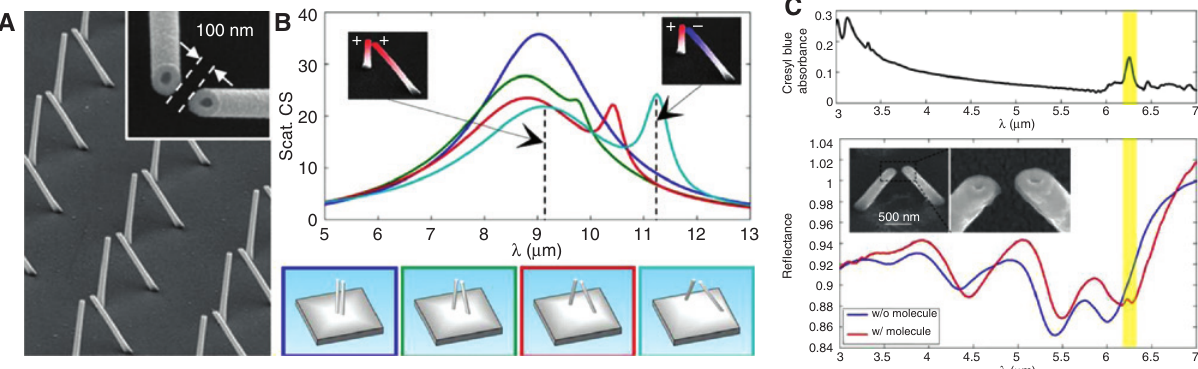
Figure 6: (A) Scanning electron microscopy (SEM) image of fabricated nanorod dimers. (B) Scattering cross-section spectra for different tilting angles α of the dimers. (C) Above: Measured IR spectrum of bulk BCB fluorophore. Below: FTIR reflectance spectra measured before (blue line) and after (red line) deposition of BCB on top of a nanorod dimer array (height 930 nm, α = 32 ° , β = 180 ° , gap 100 nm, pitch 5 μ m). The insets report SEM images of one dimer of the array after deposition. Adapted with permission from Ref. [91]. Copyright 2015 American Chemical